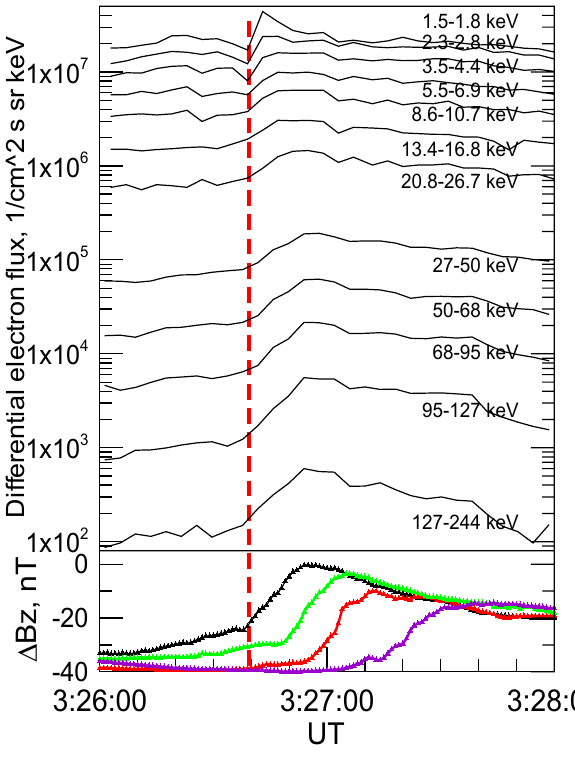
Fig. 6. Differential omni-directional electron flux variations in the energy range 1–150keV from RAPID and PEACE at C1 (a) ; B Z variations at four Cluster spacecraft (b)